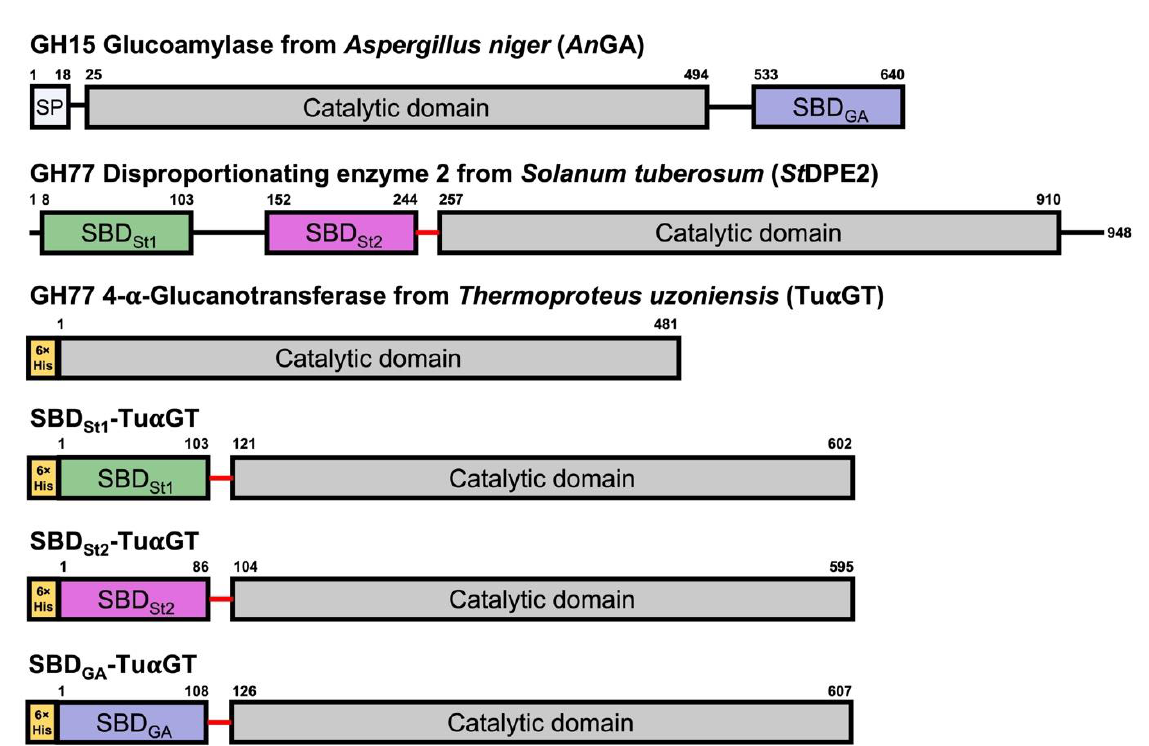
Figure 1. Domain architecture of amylolytic enzymes used in the present study. Aspergillus niger glucoamylase ( An GA), Solanum tuberosum disproportionating enzyme 2 ( St DPE2), 4- α -glucanotransferase from Thermoproteus uzoniensis (Tu αGT), and the three SBD- TuαGT fusions (SBD St1 - TuαGT, SBD St2 - TuαGT, and SBD GA - TuαGT) containing full length TuαGT and an SBD of family CBM20 connected to the N-terminus via an 18-residues linker (red: TTGESRFVVLSDGLMREM).